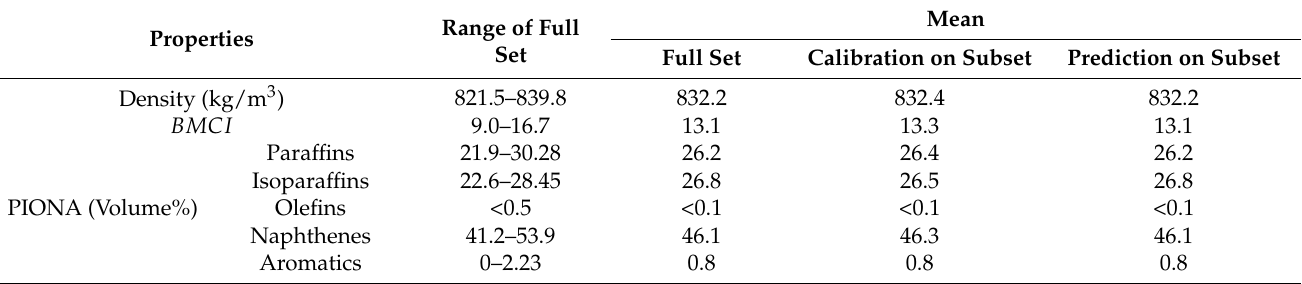
Table 1. Measured properties of